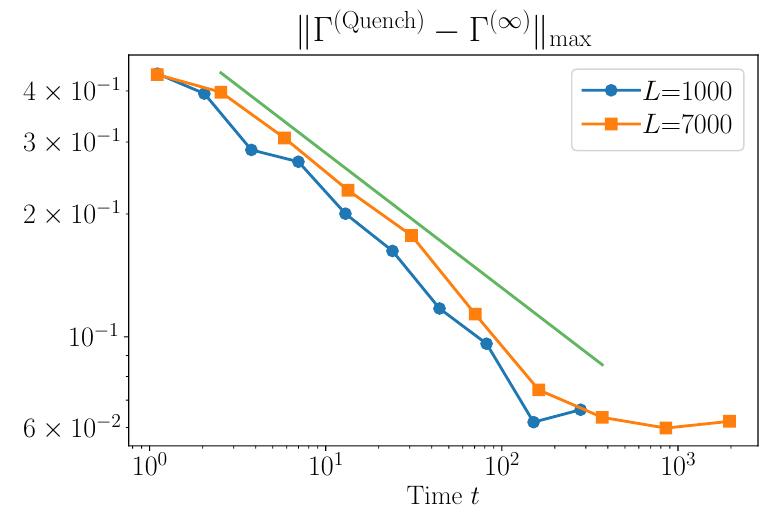
Figure 3: We have sampled a thermal state of the Anderson insulator Γ ( Quench ) for sys- tem sizes L = 1000,7000 at β = 1 and w = 5 as an example of a strongly disordered initial condition. We find that after switching off the on-site disorder the ensuing non-equilibrium evolution under the nearest-neighbour hopping model leads to re- laxation towards the infinite-time average Γ ( ∞ ) which is indeed quantified in the ∼ t − α . The green line functional form by a power-law in time (cid:107) Γ ( Quench ) − Γ ( ∞ ) (cid:107) max is a guide to the eye scaling as ∼ t − 1 / 3 . At some point, the power-law relaxation must level off either due to finite system size, with the ultimate small parameter ( d ) ∼ L − α , or due to the specific quasiparticle content being ε ∼ t − α R X